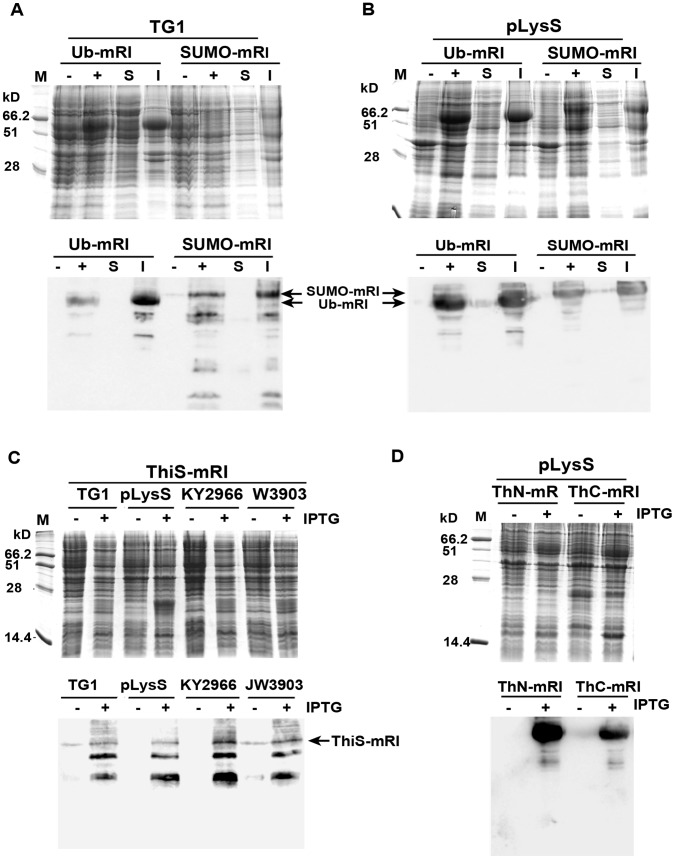
Expression of mRI with different tag fusion.mRI with ubiquitin (Ub) or SUMO fusion were expressed in (A) E. coli TG1 or (B) E. coli BL21 (DE3) pLysS. (C) ThiS fusion of mRI was expressed in E. coli TG1, and protease-deficient strains BL21 (DE3) pLysS, KY2966 and JW3903. (D) mRI with the N-terminal half (ThN-mRI) or C-terminal half (ThC-mRI) of ThiS fusion were expressed in E. coli BL21 (DE3) pLysS. Total cell lysate from uninduced (−) or induced (+) cells with IPTG, and the soluble (S) or insoluble fraction (I) of induced cells were resolved on 10% SDS-PAGE, shown in each upper panel. Western blot probed by anti His-tag antibody was shown in each lower panel. Expressed products migrating at the expected molecular weight are indicated by arrows.